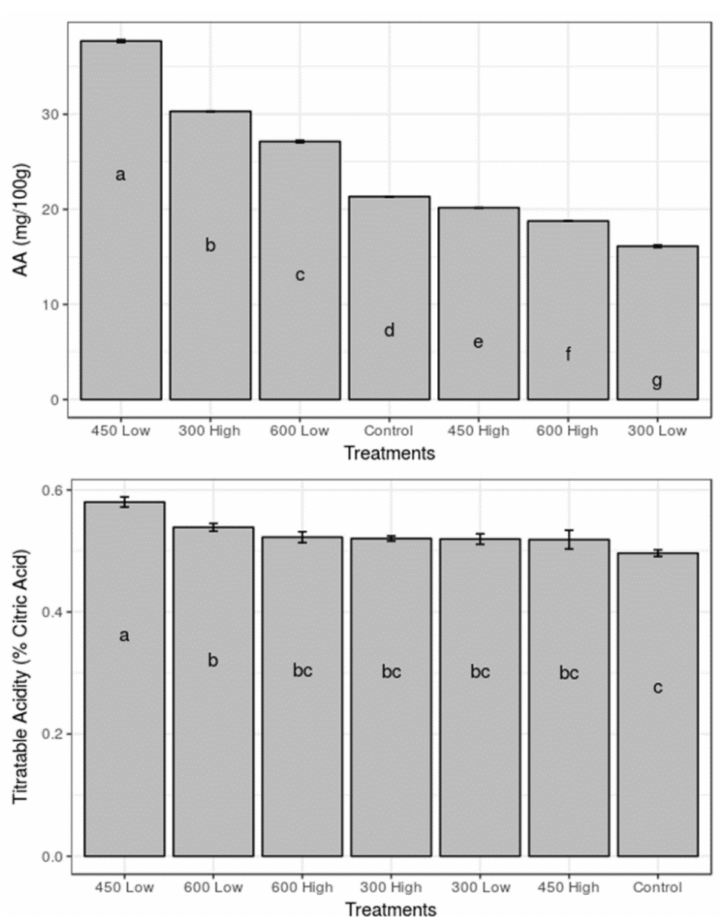
Figure 5. Total ascorbic acid (AA) and titratable acidity (TA) of tomatoes cultivated in the standard (control) and biochar amended media. Bars represent standard error ( n = 6 for AA and n = 3 for TA). Different letters show significant difference ( p < 0.05) between treatments.